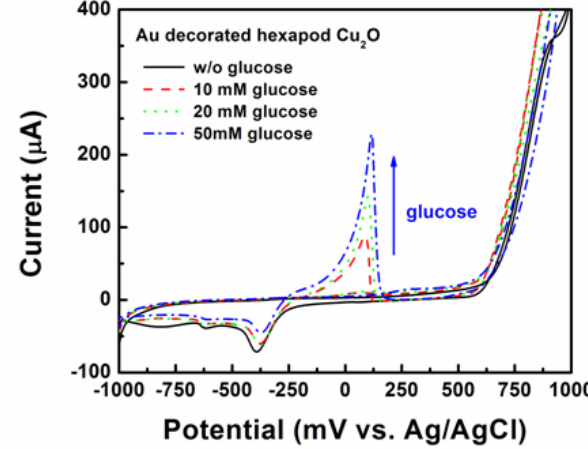
Figure 10. Cyclic voltammograms of hexapod Au/Cu with additions of 0, 10, 20, and 50 mM glucose at a scan rate of 10